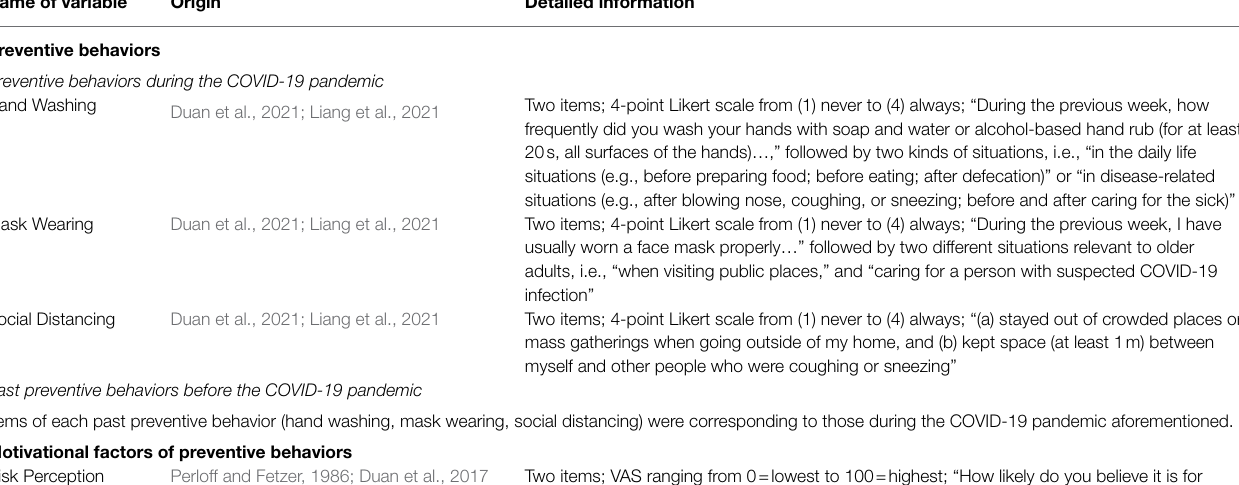
TABLE 1 | Overview of the measurement tools regarding preventive behavioral and their motivational and volitional factors. Name of